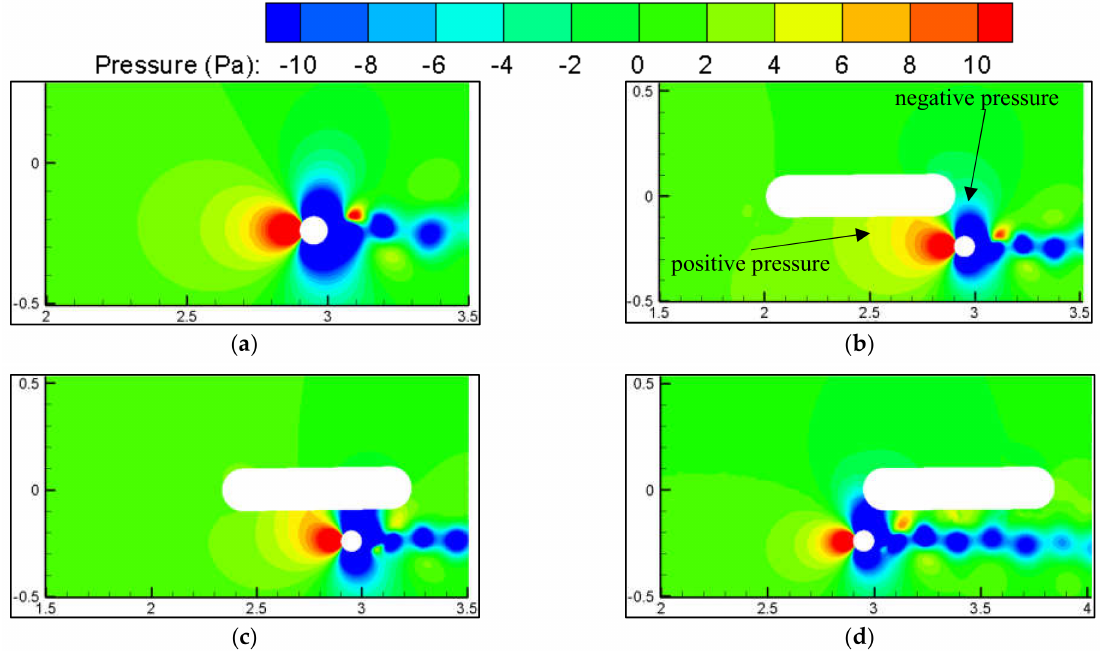
Figure 21. Schematics of the flow pressure distribution around the pier: ( a ) No ship; ( b ) Ship bowled up to the pier; ( c ) Bow moves over the pier; ( d ) Stern sailing over the pier.